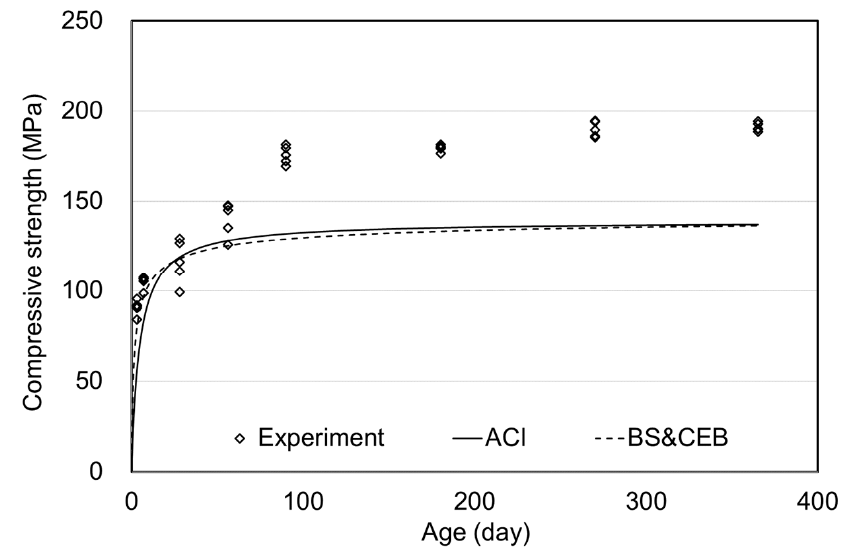
Figure 5. Comparative results of moist curing compressive strength.